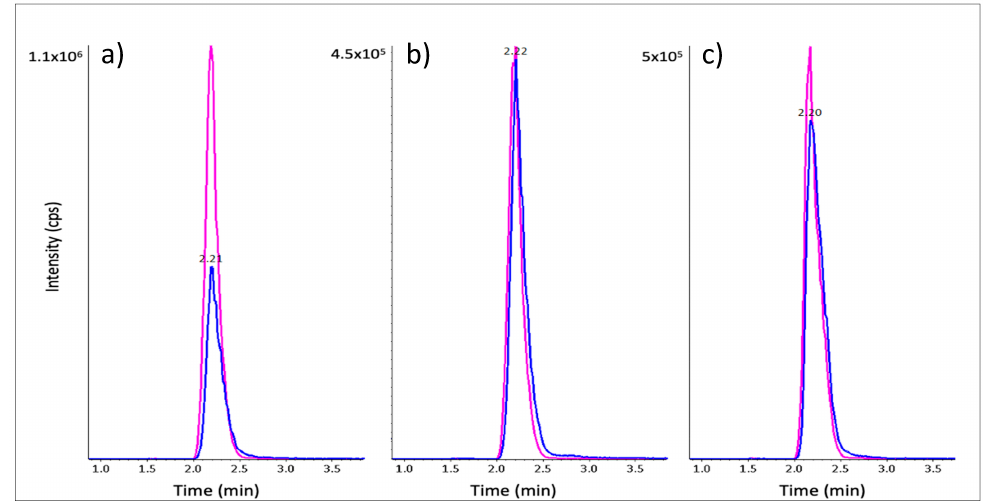
Figure 3. Representative LC-MRM chromatograms of β -ODAP (blue) and of Gly-Asp (pink) in a calibration standard at 10 µM β -ODAP in 0.1 mg/mL BSA ( a ), L. sativus crude extract (diluted 200-fold) ( b ) and dialysed extracts (diluted 10-fold) ( c ). Table 4. β -ODAP concentrations found in L. sativus, CDC Amarillo, and yellow pea extracts. An external calibration curve of β -ODAP was used for quantitation, using Gly-Asp as the internal standard.